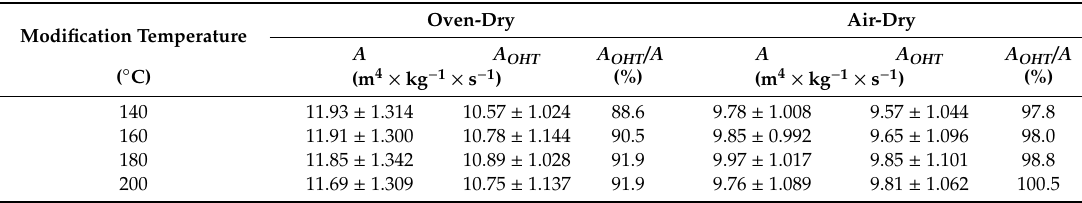
Table 4. Mean value of spruce wood acoustic constant, before and after modification, at di ff erent temperatures and moisture contents; ±